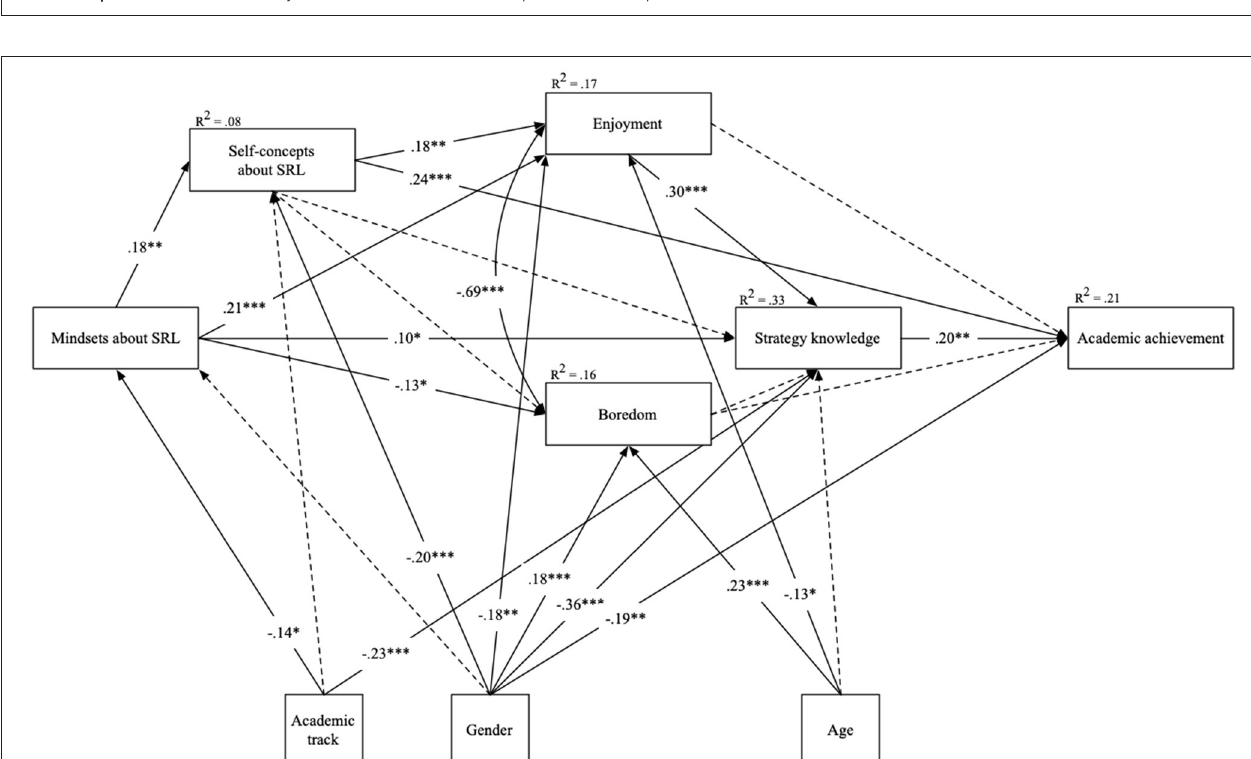
However, researchers need to conduct longitudinal studies to investigate this